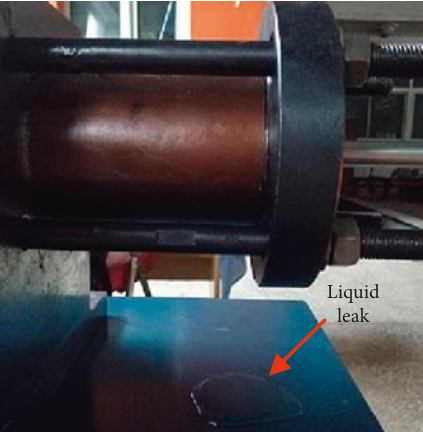
Figure 5: Leakage of sealing